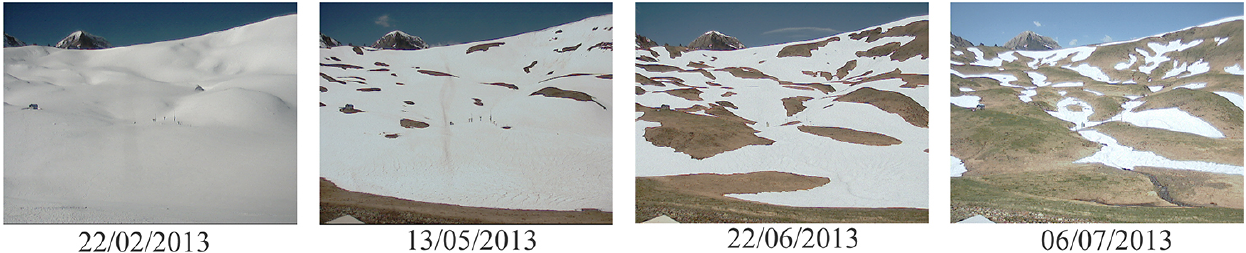
Figure 6. Example of a sequence of four photographs for the 2012/13 snow season, showing the evolution of the snow